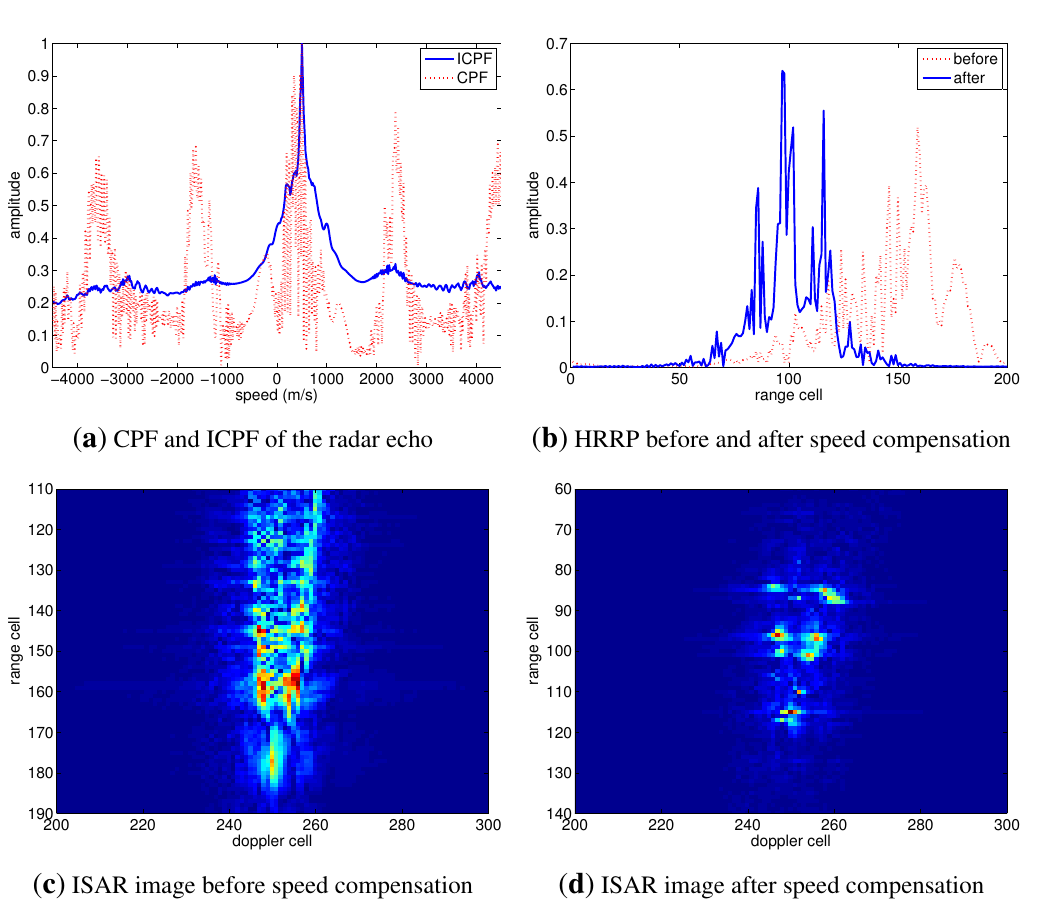
Figure 4. Speed compensation results of the simulated radar target with a speed of 500 m/s. CPF, cubic phase function; ICPF, inverse CPF; HRRP, high-resolution range